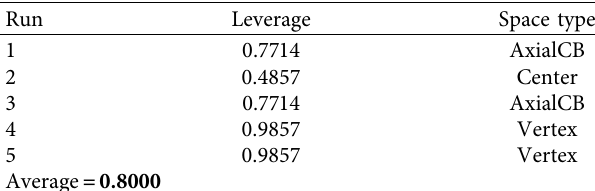
Table 3: Measures derived from the information